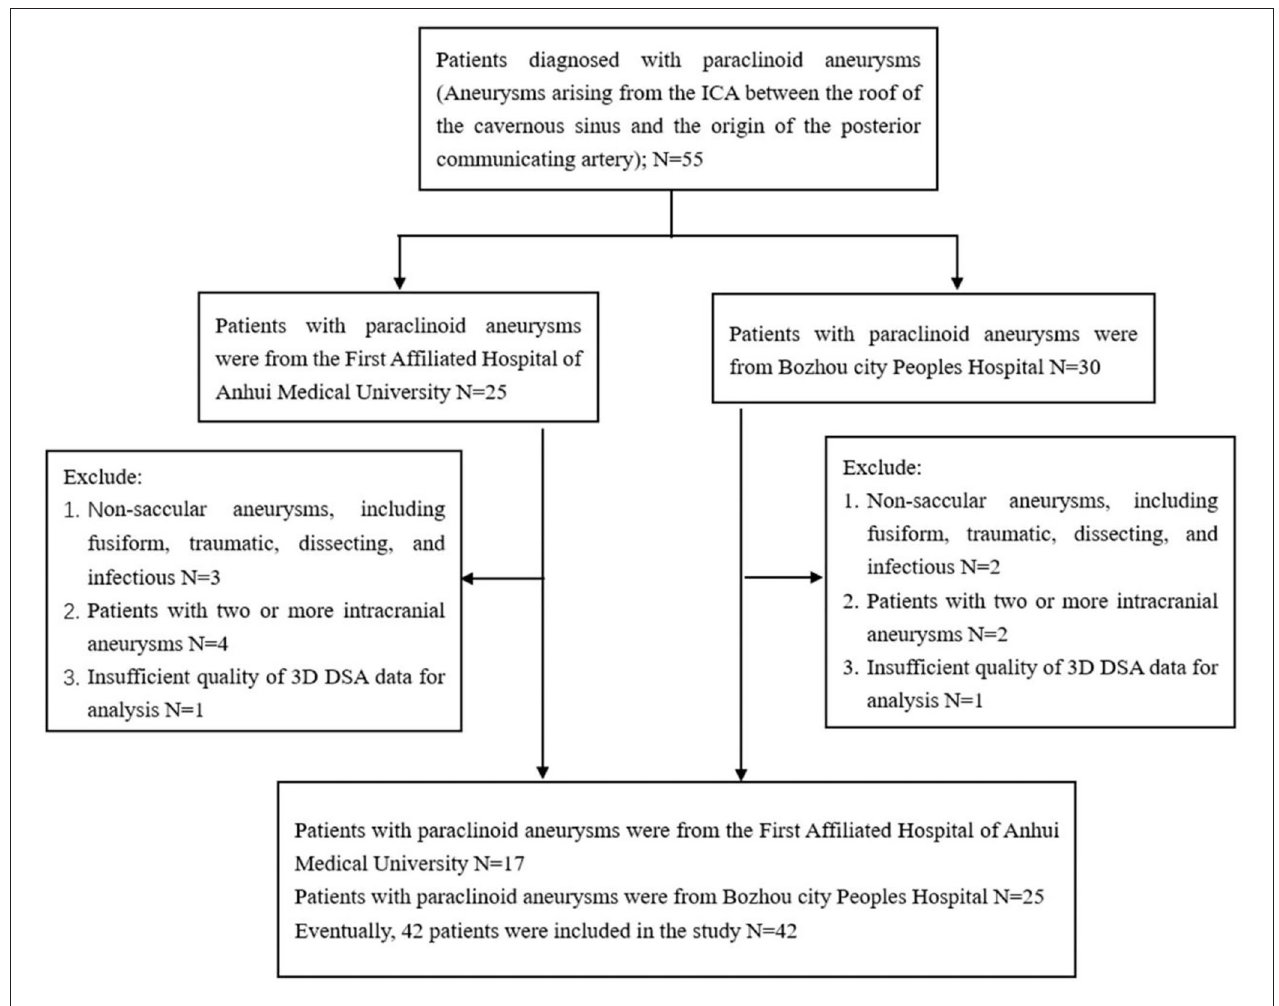
FIGURE 1 | The flow chart of paraclinoid aneurysms participant